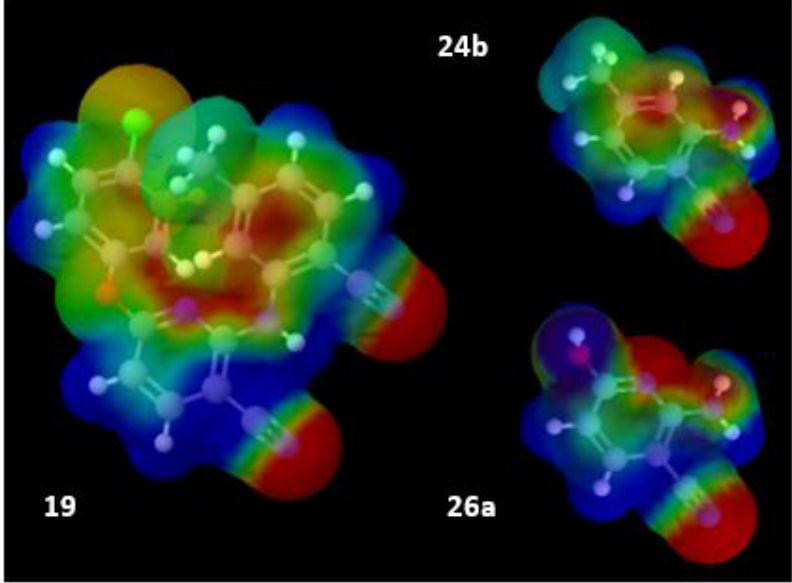
Figure 8. MEP of 19 with comparison to 3-cyanopyridine ( 26a) , and 4-methylbenzonitrile ( 24b ).